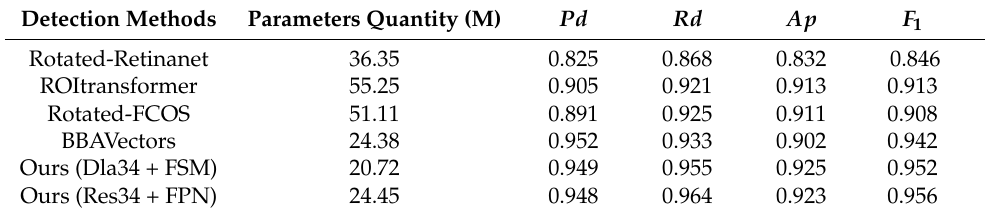
Table 4. Experimental Results of Different Detection